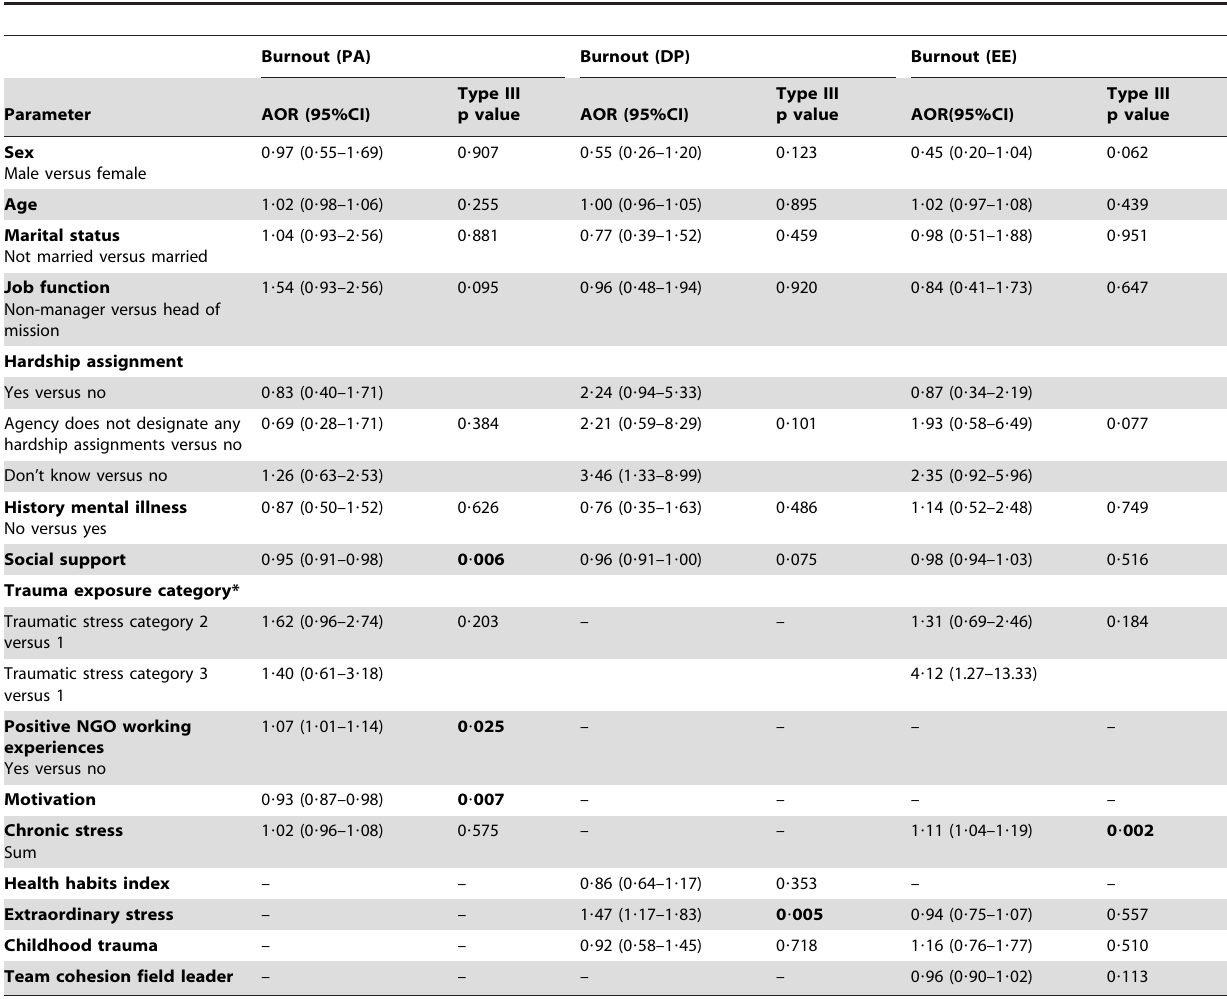
Table 5. Longitudinal multivariate generalized estimating equations model: demographic variables, exposure, organizational, and other risk and mitigating factors across time affecting burnout personal accomplishment (PA), depersonalization (DP), and emotional exhaustion (EE)